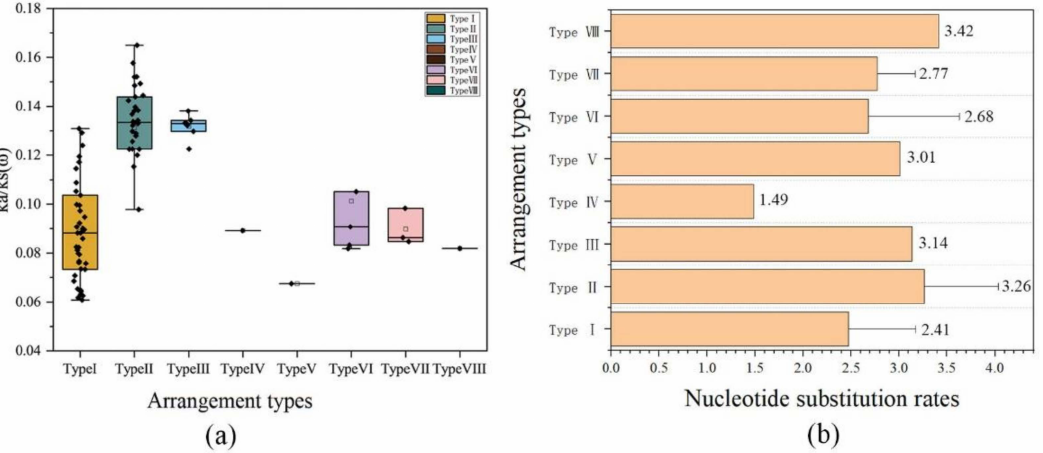
Figure 8. Analysis of natural selection strength and nucleotide substitution rates. ( a ) Histogram of the mean ka/ks of the combined dataset of 13 protein-coding genes. ( b ) Nucleotide substitution rates for the eight gene arrangement